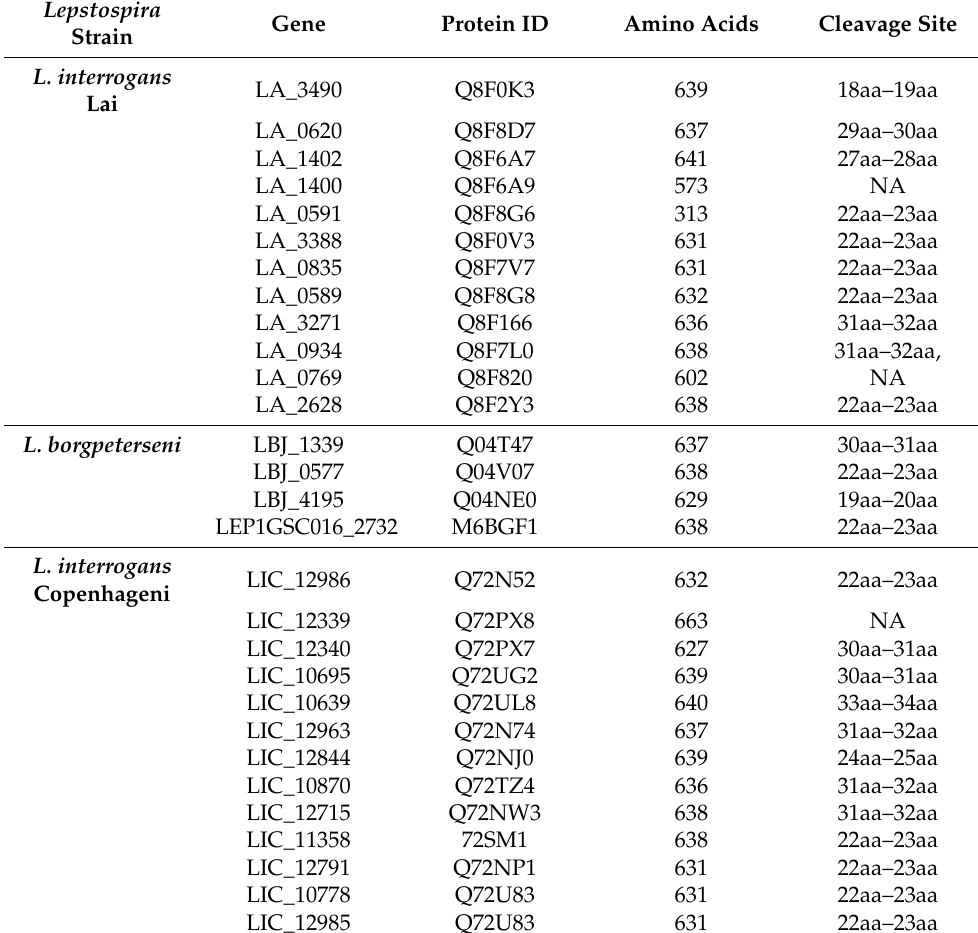
Table 1. General List of virulence-modifying proteins from L. interrogans Lai, L. interrogans Copen- hageni and L. borgpeterseni , gene code, amino acids amount, and signal peptide prediction using Signal P 6.0 server, all based on Fouts et al. [16] and Putz et al. [43] data. Lepstospira Gene Protein ID Amino Acids Cleavage Strain